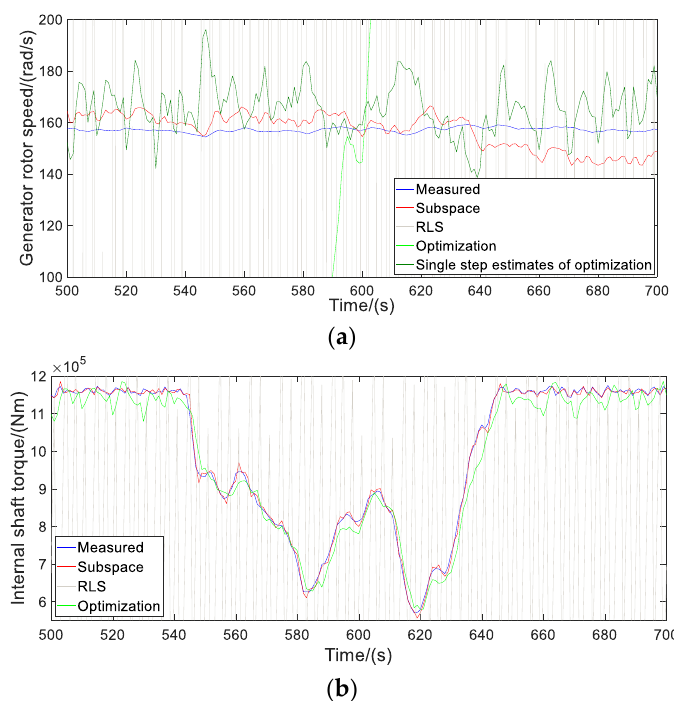
Figure 8. ( a ) Comparison of generator rotor speed under scenario Type 1; ( b ) Comparison of internal shaft torque under scenario Type 1. Energies 2019 , 04 , x FOR PEER REVIEW